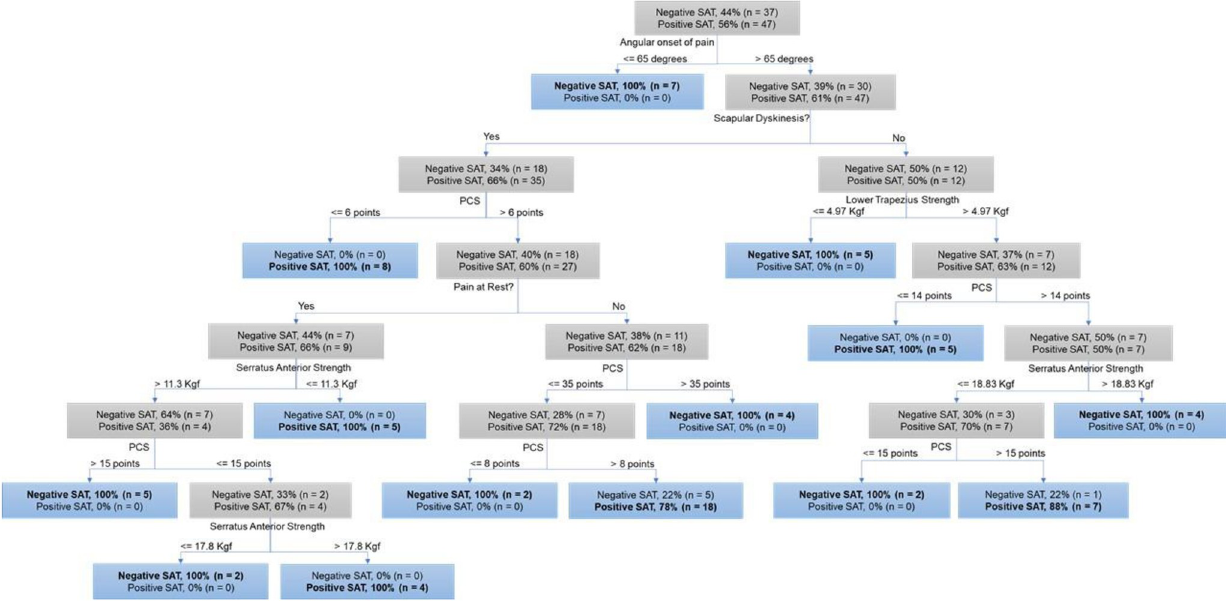
Fig 2. Classification tree of the occurrence of a positive and negative Scapular Assistance Test. The bolded category in each node corresponds to the predicted category. Abbreviations: SAT, Scapular Assistance Test; DASH, Disabilities of the Arm, Shoulder and Hand; PCS, Pain Catastrophizing Scale. Blue boxes indicate leaves of the tree. Gray boxes indicate intermediate nodes of the